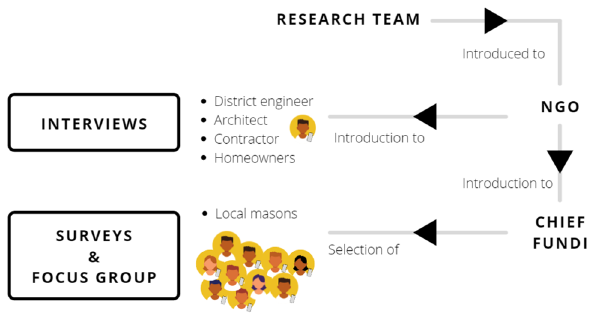
Fig. 2 Methodology overview for assessing the use of smartphones